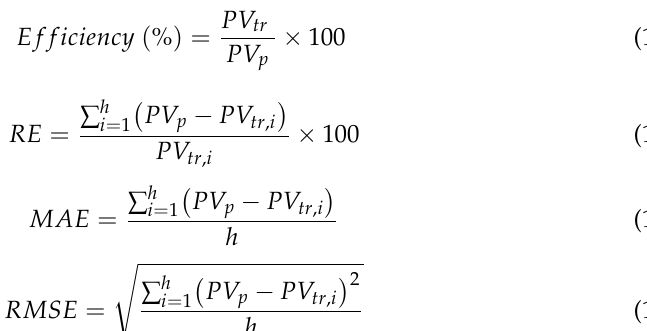
Figure 11. Case 3: comparison of ( a ) power, ( b ) voltage, ( c ) current, ( d ) duty cycle of SGO, DFO, ABC, PSOGS, and PSO.